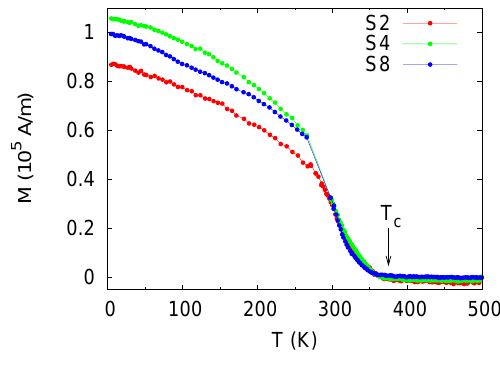
Fig. 2. Temperature dependences of magnetization for all the films in 100 mT field. The measurement were carried out in two parts from 5 K to 275 K and from 300 K to 500 K with di ff erent measuring configurations. This enables the use of the wide tem- perature range, but causes the lack of measuring points near 300